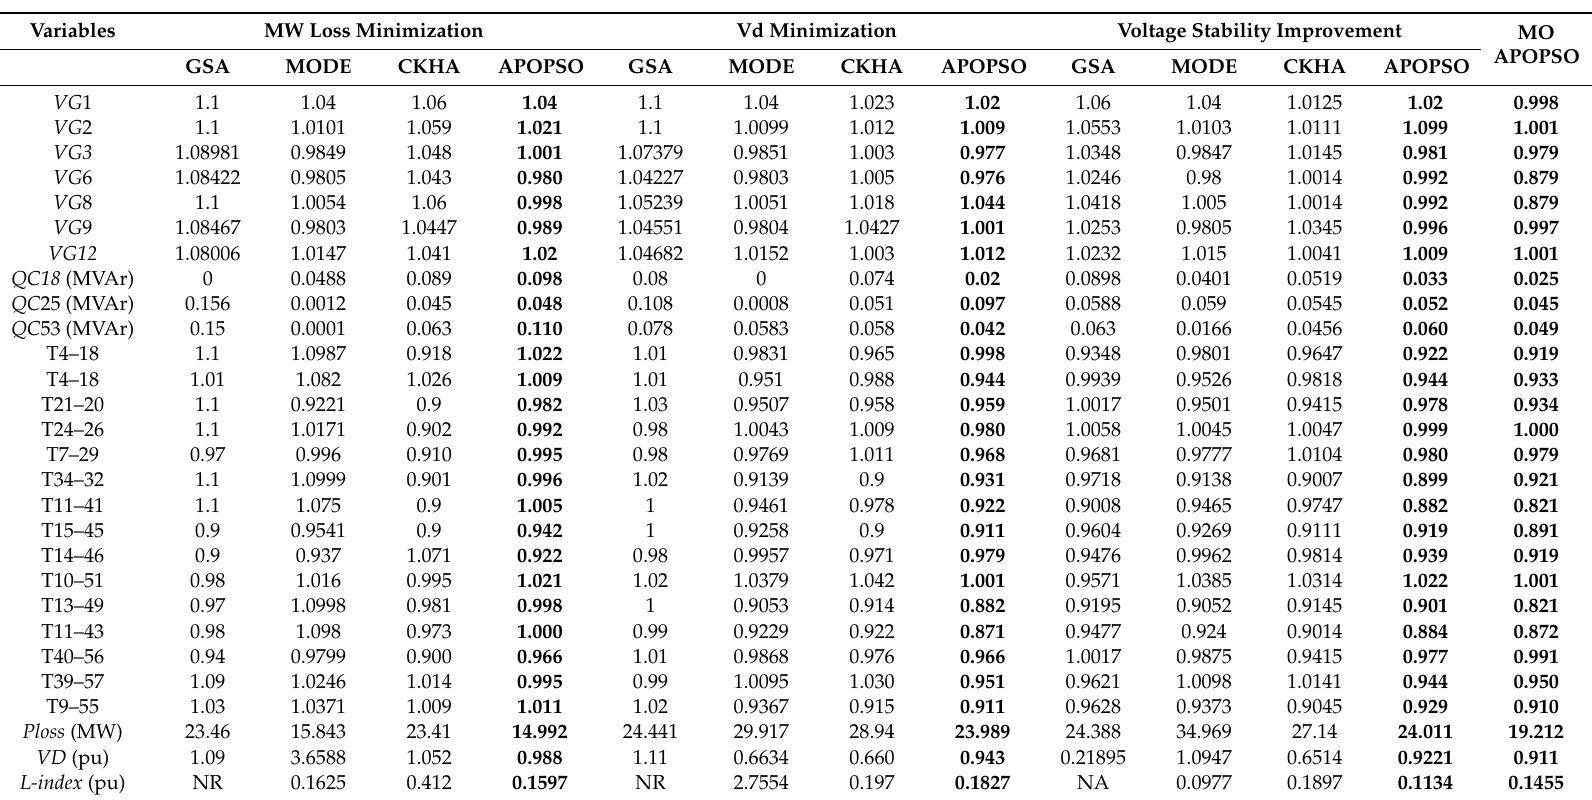
Table 5. Analysis and comparison of results for the IEEE 57 test